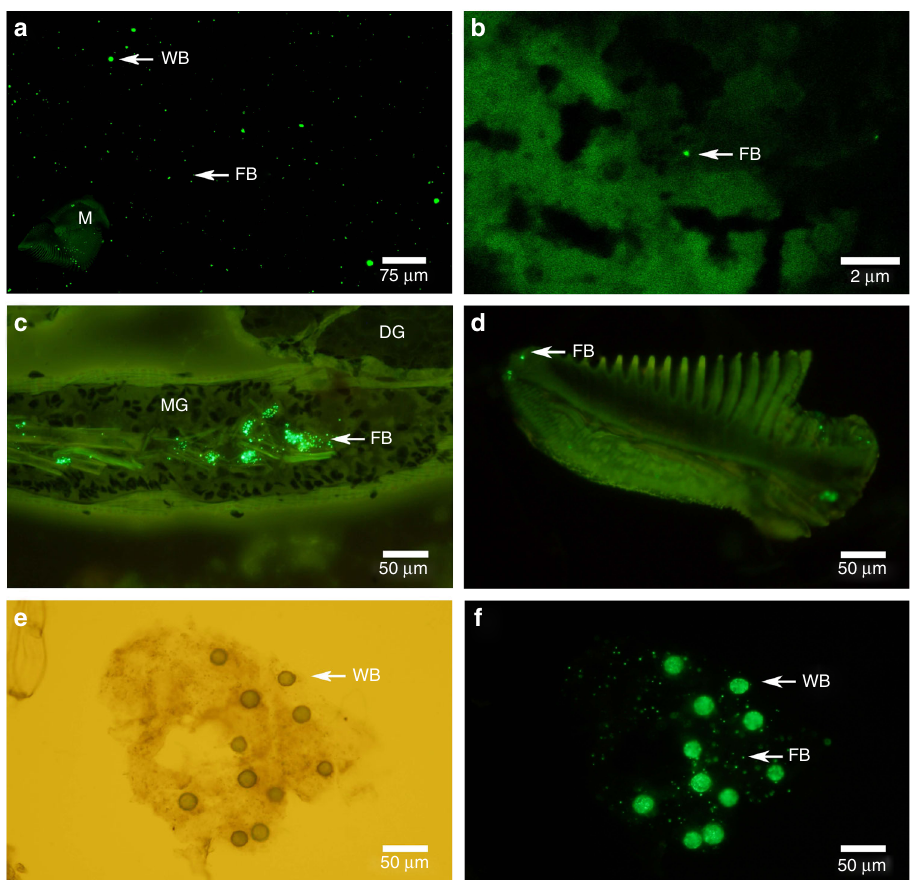
Fig. 3 Fate of polyethylene beads and fragments after ingestion by Antarctic krill. Krill ( n = 17) were used for histological analysis. a Beads on a fi lter paper isolated from digested krill with auto fl uorescent mandible, b Digestive gland tissue, c Midgut and digestive gland tissue, d Mandible with polyethylene fragments embedded in the surface, e and f Faecal pellet with polyethylene beads under bright fi eld and fl uorescence microscopy. WB: whole bead, FB: fragmented bead, M: mandible, DG: digestive gland, MG: